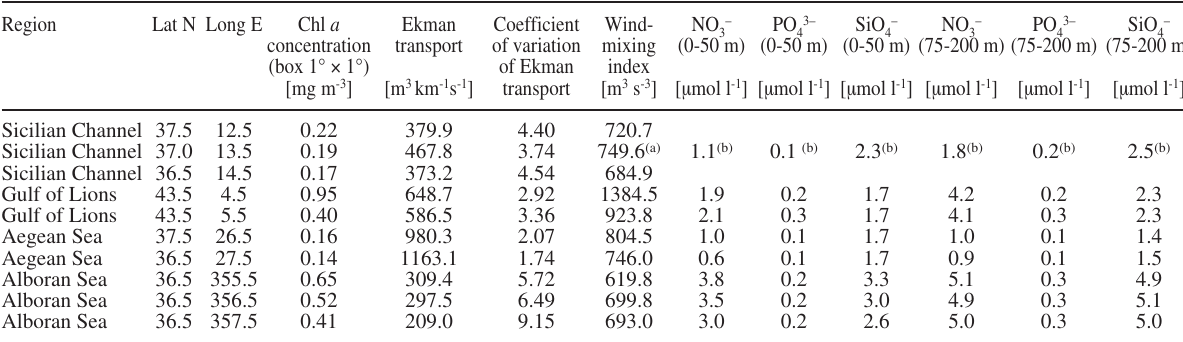
Table 1. – Average annual climatological values of Chl a concentration, Ekman transport, coefficient of Variation of Ekman transport, wind- mixing index from September 1997 to December 2007 (May 2007 for wind-mixing index only), and the mean values of nitrate, phosphate and silicate in the mixed layer waters (0-50m) and in sub-surface waters (75-200 m), mainly obtained in the period from 1960 to 2004 in the 1° × 1° cells of Figure 1. Latitude and longitude represent the centre of a 1° × 1° cell. See the section “Materials and Methods” for further explanations.